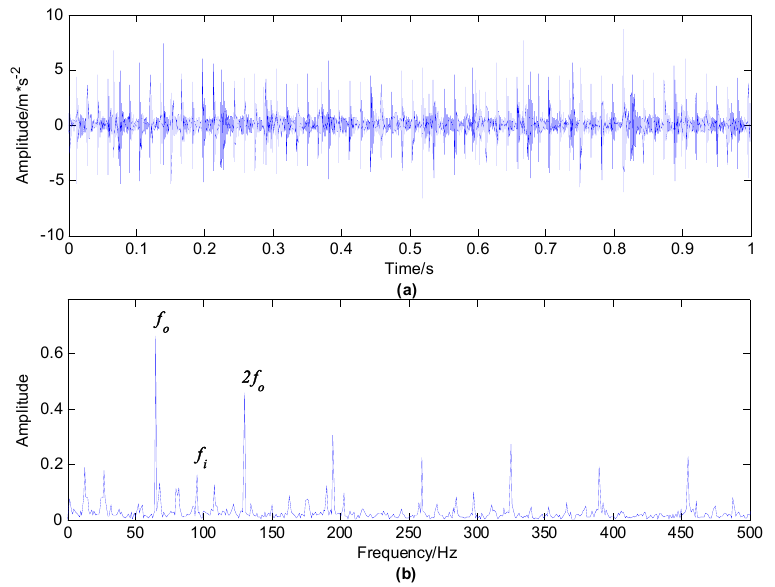
Figure 3. Rolling bearing signal with outer and inner race compound fault: ( a ) time waveform; ( b ) envelope spectrum.